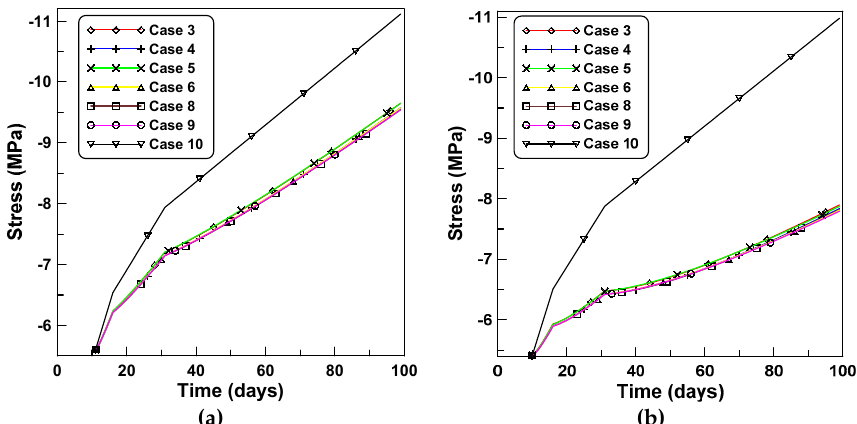
Figure 11. Concrete stresses based on six constitutive formulations: ( a ) analysis of case A and ( b ) analysis of case B.